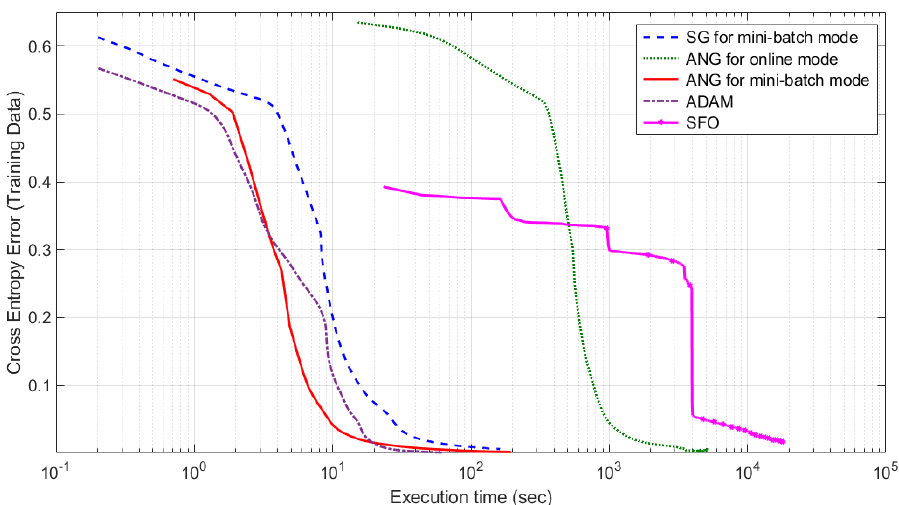
Figure 5. Change of errors for spiral data classification depending on the number of epochs.